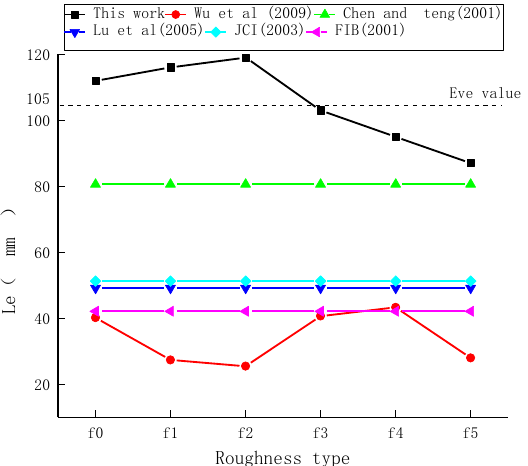
Figure 12. Comparison of effective bond length among different models.